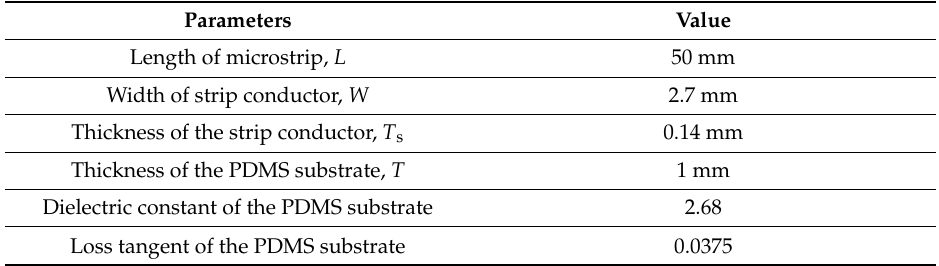
Table 1. The geometric parameters of designed microstrip.